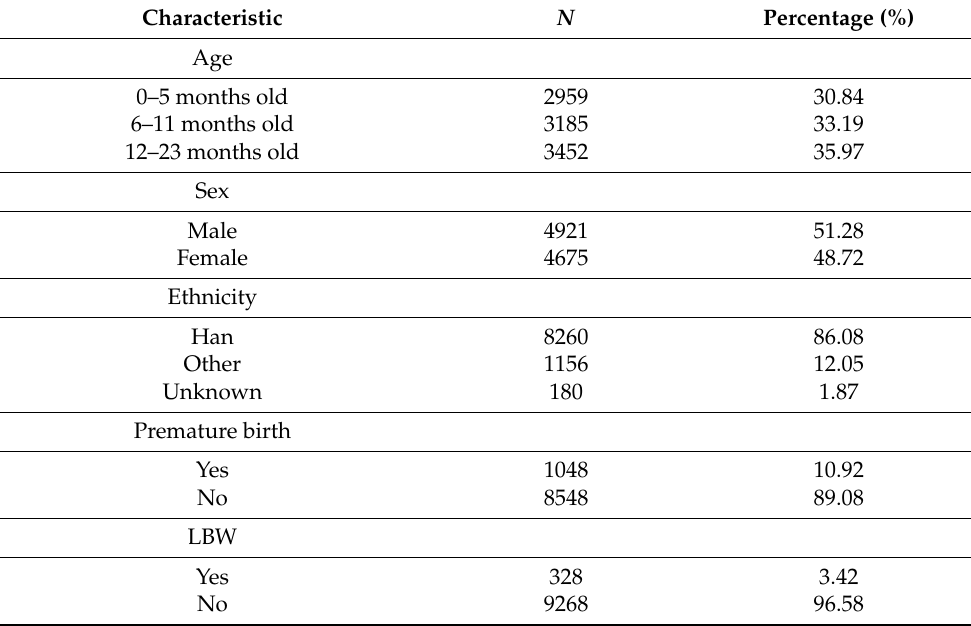
Table 1. Sample status of infants and young